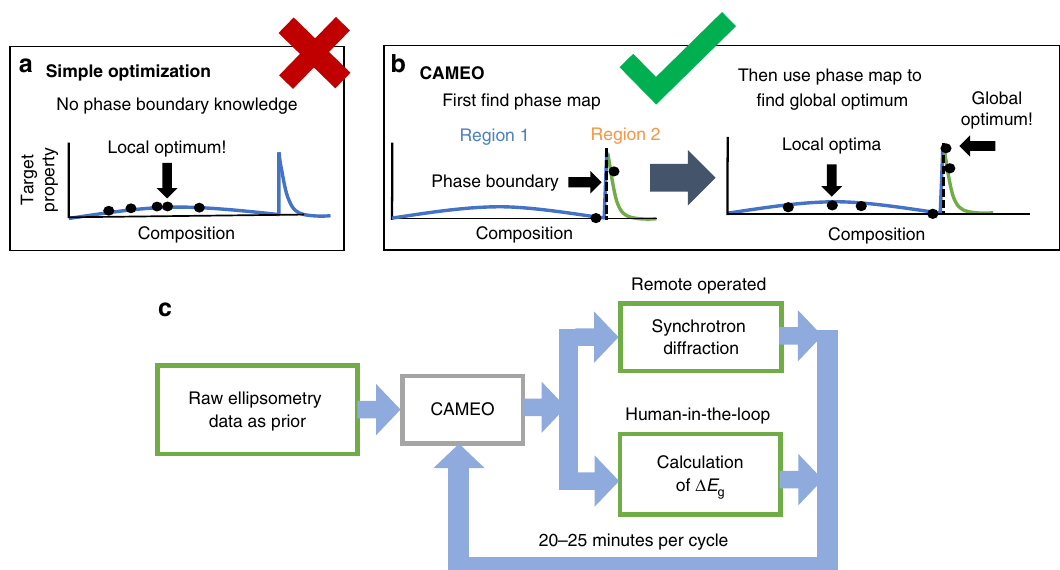
Fig. 2 Comparison of materials optimization schemes. a Simple optimization seeks to identify the property optimum with a mixture of exploration and exploitation without knowledge of the composition-structure-property (CSP) relationship. These methods are more likely to get caught in local optima. b The phase-map-informed optimization scheme exploits CSP relationship by recognizing that the property is dependent on phase, thus including phase mapping in the search for the optimum. (i) Phase-mapping steps and ii) materials optimization step that exploits knowledge of the phase boundaries. This allows a search for phase region dependent optima. c The Ge – Sb – Te CAMEO work fl ow began with incorporating raw ellipsometry data as a phase- mapping prior. On each iteration, CAMEO selects a material to measure for X-ray diffraction and concurrently requests an expert to calculate Δ E g for that material. Each cycle takes 20 – 25